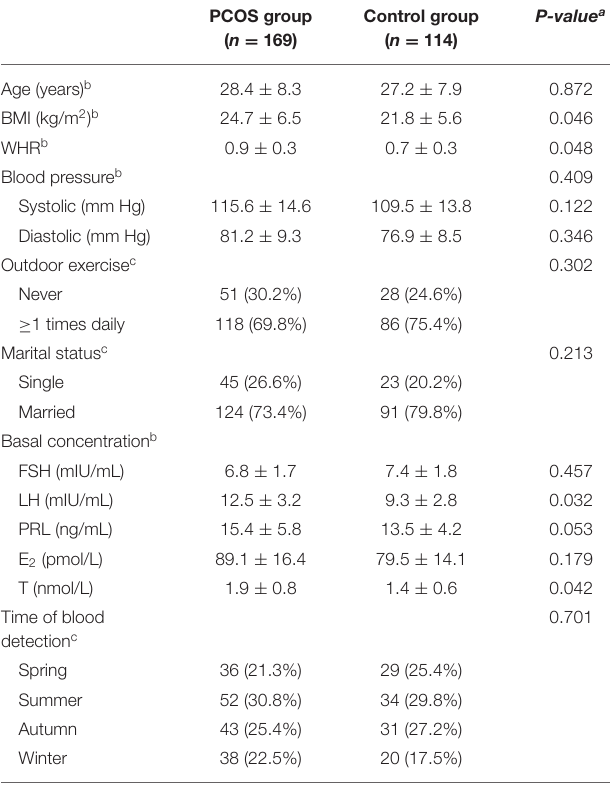
a T-test or chi-square test. b Data are presented as mean ± SD. c Data are presented as number(%).